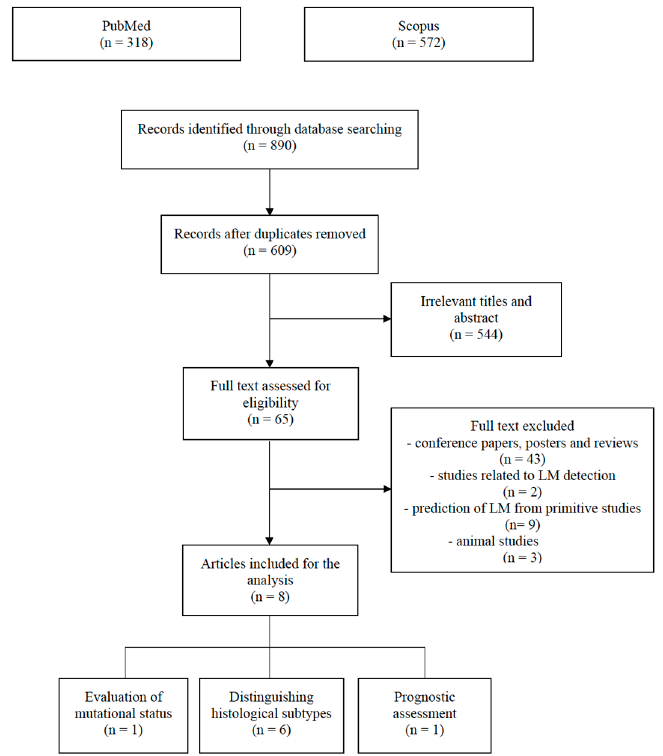
Figure 1. PRISMA flow chart illustrating the inclusion and exclusion criteria for article search.